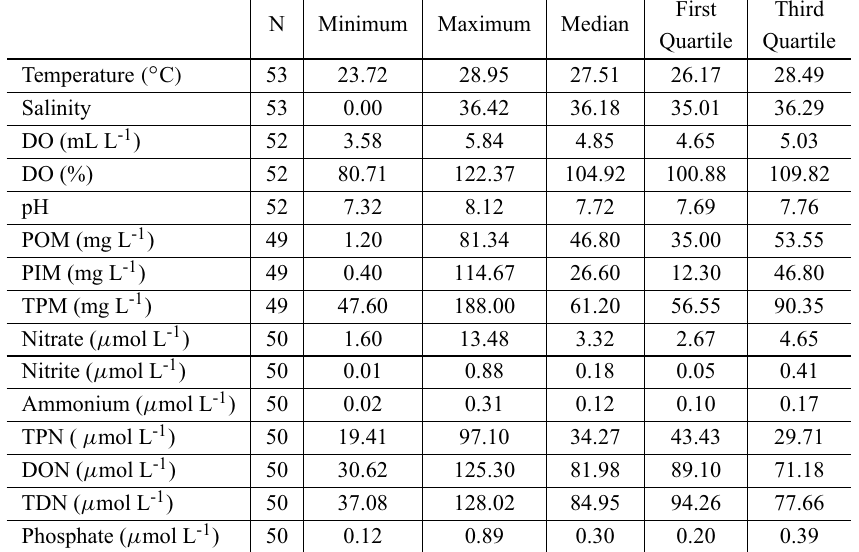
Descriptive statistics of the abiotic and chlorophyll a data recorded at the Amazon Continental Shelf in the aphotic layer, during the falling discharge period. Acronyms are as given in the text. N is the number of samples for which the statistical values were